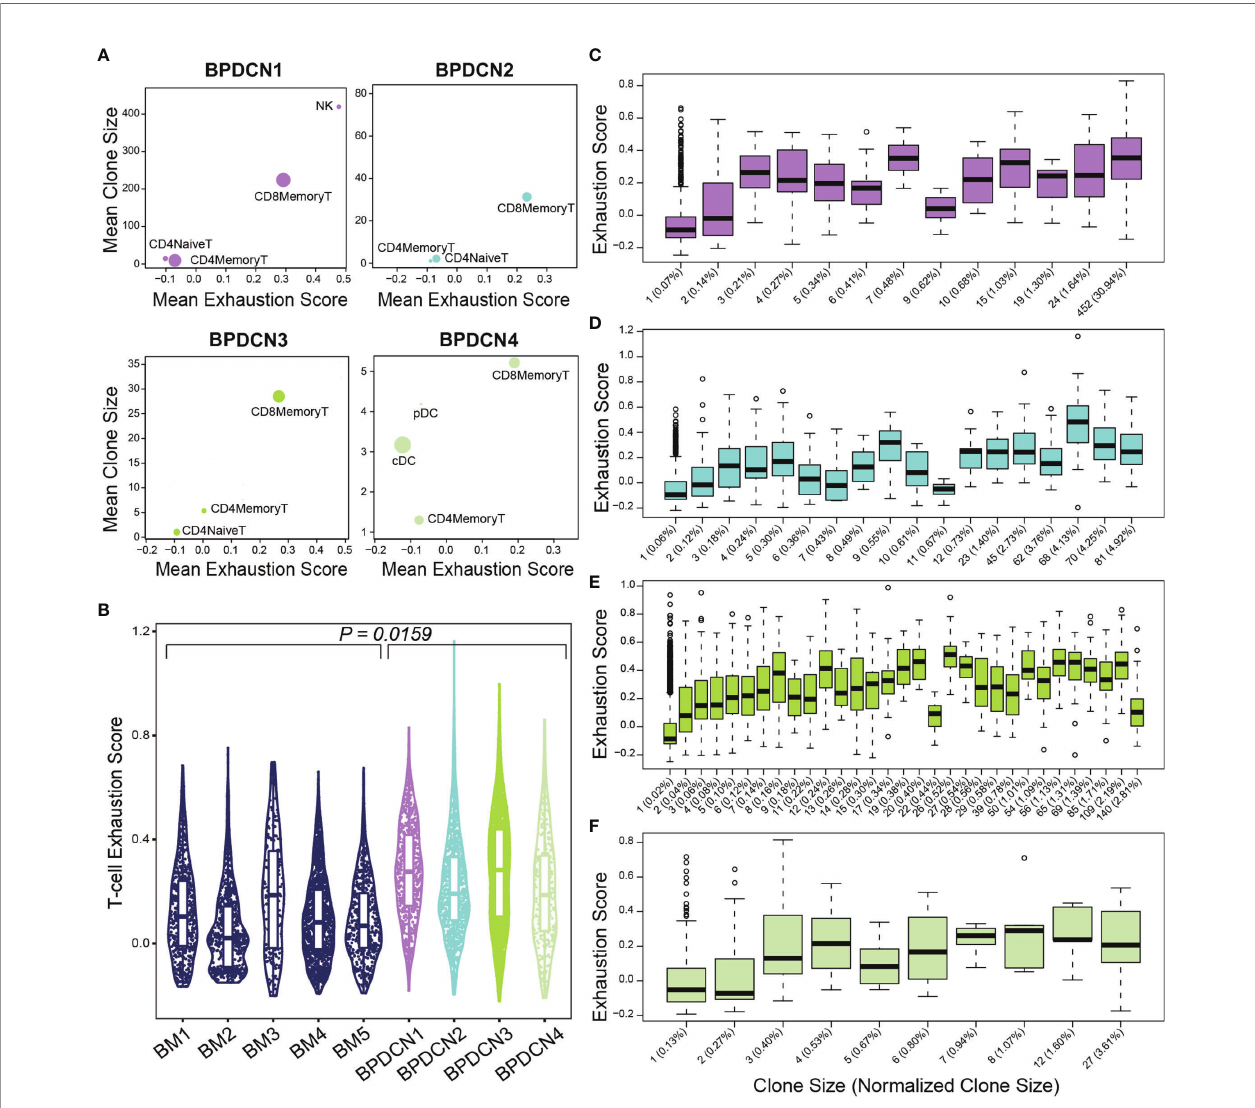
FIGURE 8 | Exhaustion scores positively correlate with clone size in BPDCN samples. (A) Scatter plots show mean exhaustion score per cluster (x-axis) versus mean clone size (y-axis). Dots are scaled by the number of cells of each cluster in the dataset. (B) Violin plot shows T-cell exhaustion signature scores in CD8+ Memory T-cells in healthy controls (BM 1-5) and BPDCN samples with T-cells (BPDCN 1-4). (C – F) Box plots of cells binned by TCR clone size (x-axis) versus exhaustion score (y-axis) for T-cells in each BPDCN 1-4 sample as C-F. Parenthetical values on the x-axis labels indicate the normalized clone